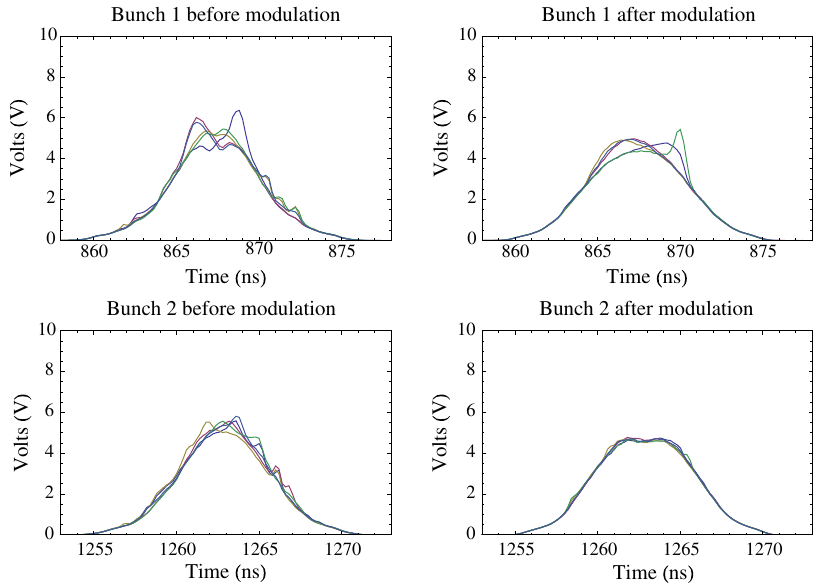
FIG. 8. The initial bunch shape can have an effect on how strongly it must be modulated to stop the dancing.